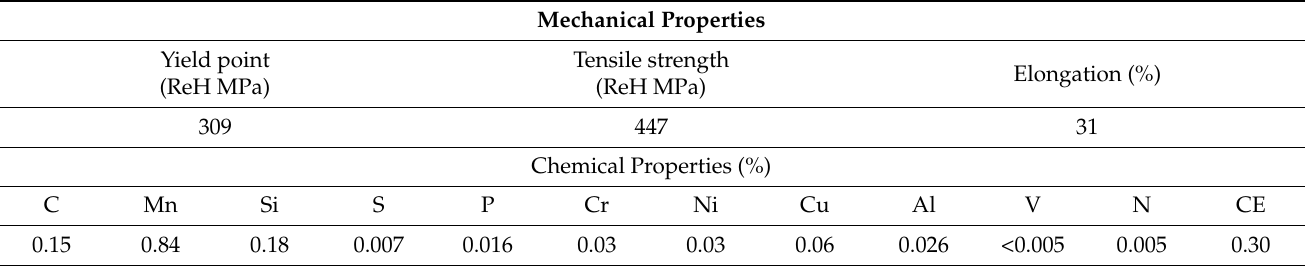
Table 1. Mechanical and chemical properties of the S275JR +